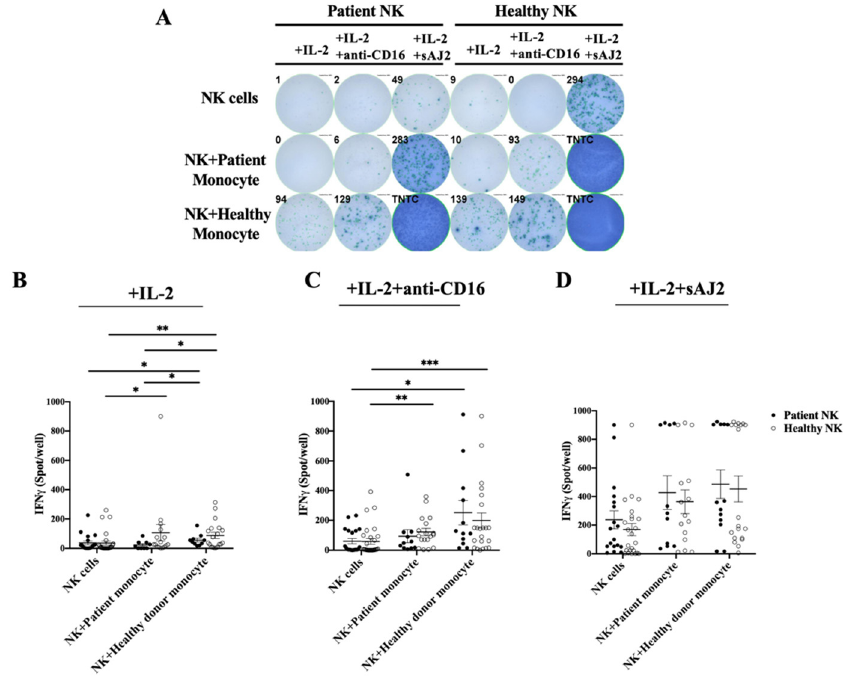
Figure 3. Cancer patients’ monocytes in comparison to healthy individuals’ monocytes are less capable of inducing IFN- γ secretion by autologous and allogeneic healthy NK cells. NK cells and monocytes of cancer patients and those of the healthy individuals were isolated from PBMCs as described in Section 2. NK cells and monocytes were treated with IL-2 (1000 U/mL) alone ( A , B ) or with a combination of IL-2 (1000 U/mL) and anti-CD16 mAbs (3 µg/mL) ( A , C ) or with a combination of IL-2 (1000 U/mL) and sAJ2 (NK cells:sAJ2, 1:2) ( A , D ). Co-cultures of NK cells with autologous and allogeneic monocytes from both the patient and healthy donor were performed. After 18 h of coculture, number of IFN- γ secreting cells were determined using ELISpot assay as spot counts. A representative experiment is shown in ( A ). Compiled data are shown in ( B – D ) ( n = 11 to 28), and data are presented as Mean ± SEM. Student t tests were performed to determine statistical significance. *** ( p value < 0.001), ** ( p value 0.001–0.01), * ( p value 0.01–0.05).